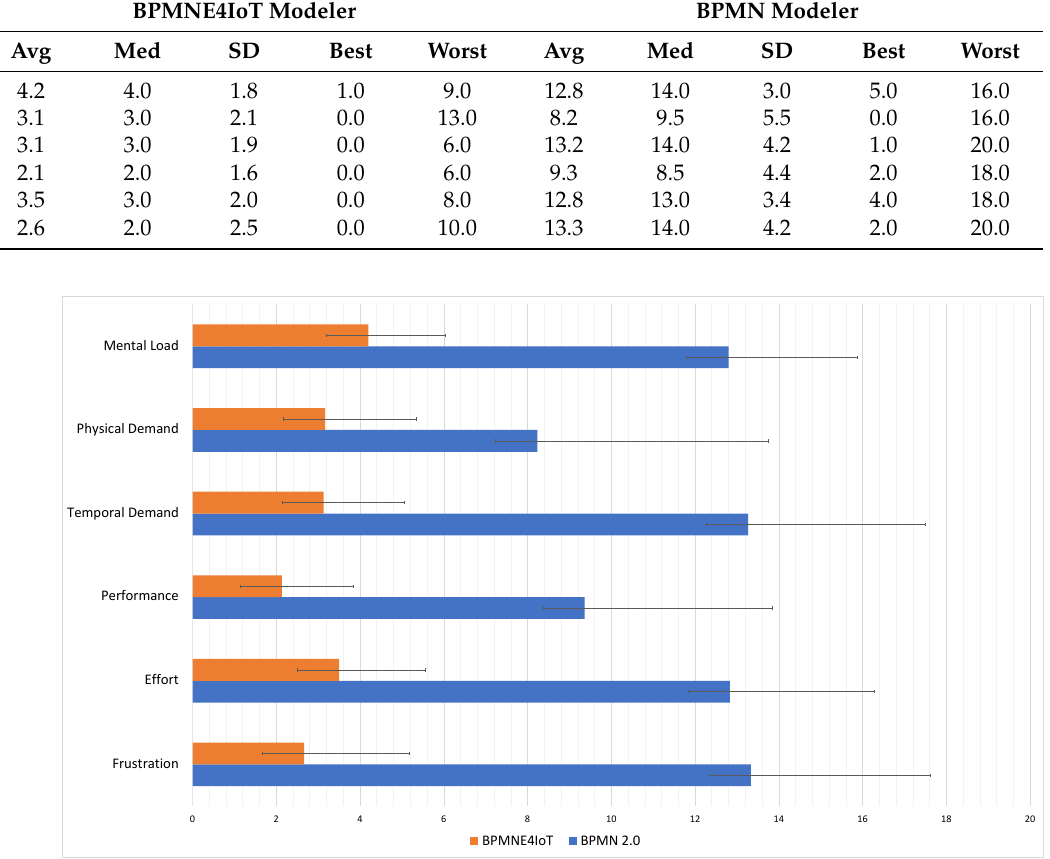
Figure 21. Comparison of TLX means and standard deviation for modeling IoT-driven